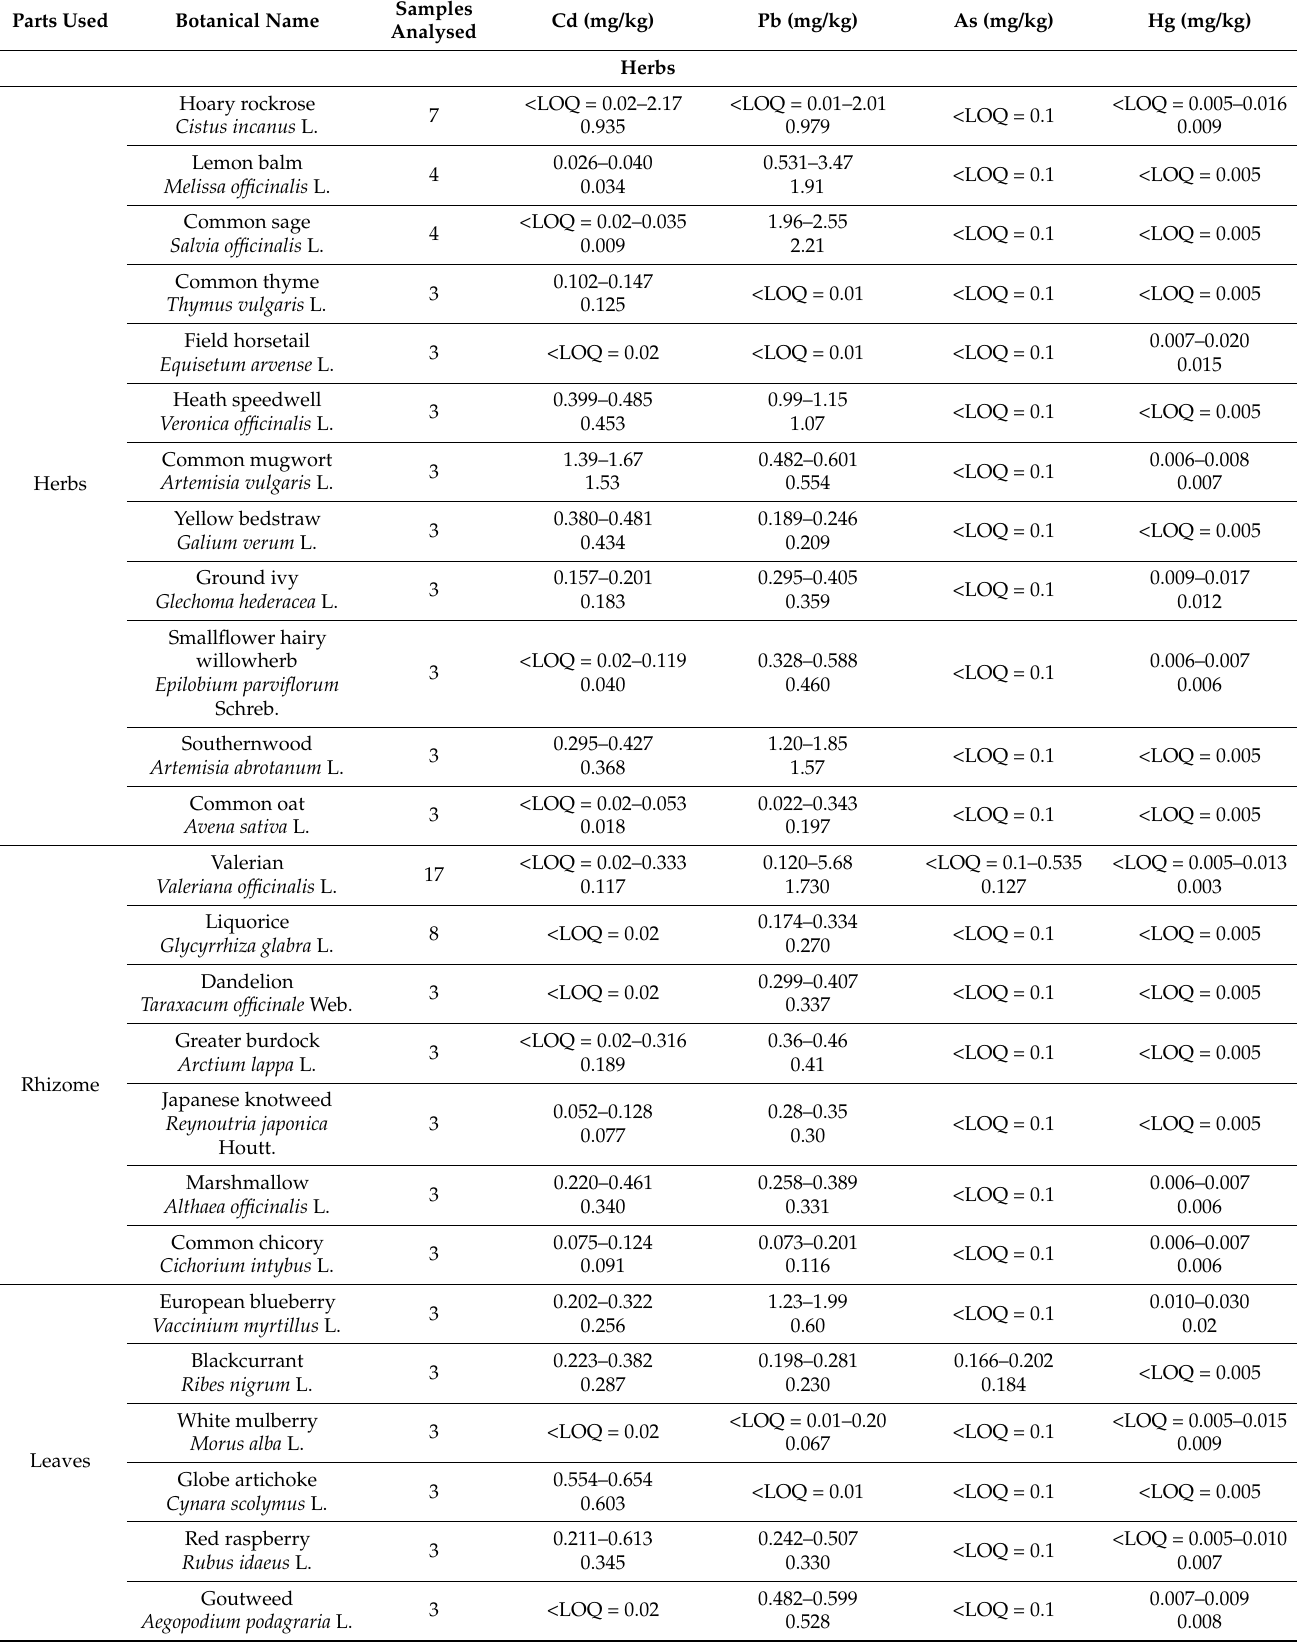
Table 2. The heavy-metal contents in selected samples of herbs, spices, tea, and